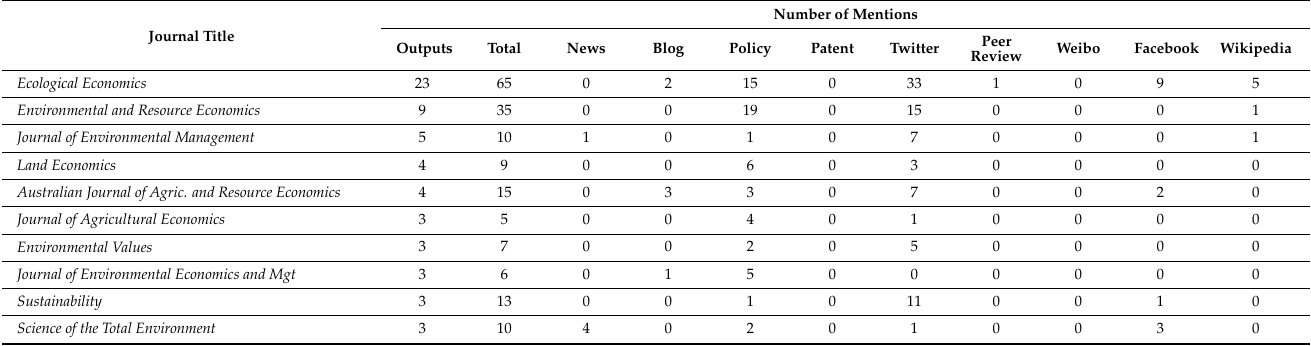
Table 2. List of journals and collections from Altmetric on environmental valuation